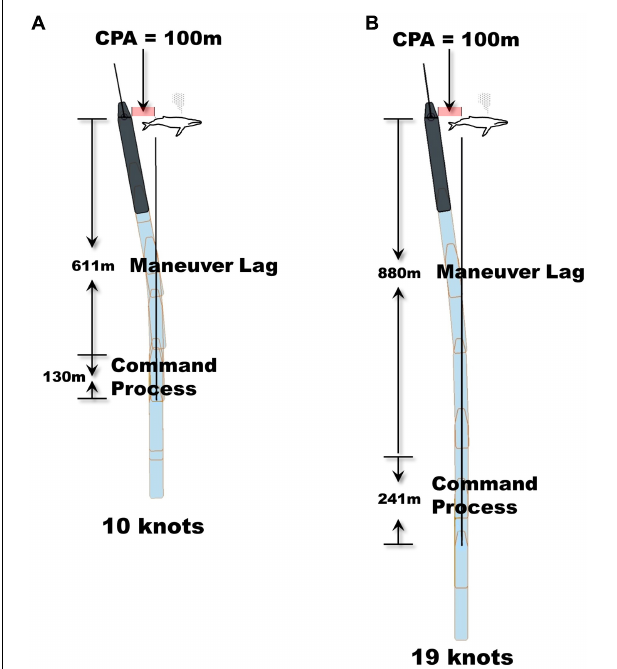
FIGURE 7 | Example of the maneuvering capability of a large cruise ship traveling at 10 knots (A) and 19 knots (B) to achieve a Closest Point of Approach (CPA) of 100 m based on defined environmental conditions and safe turning constraints and assumptions (maximum rate of turn = 10 degrees per minute; see text). These scenarios depict situations that, should a mariner want to achieve a ‘near miss’ of a surfacing humpback whale, the ship